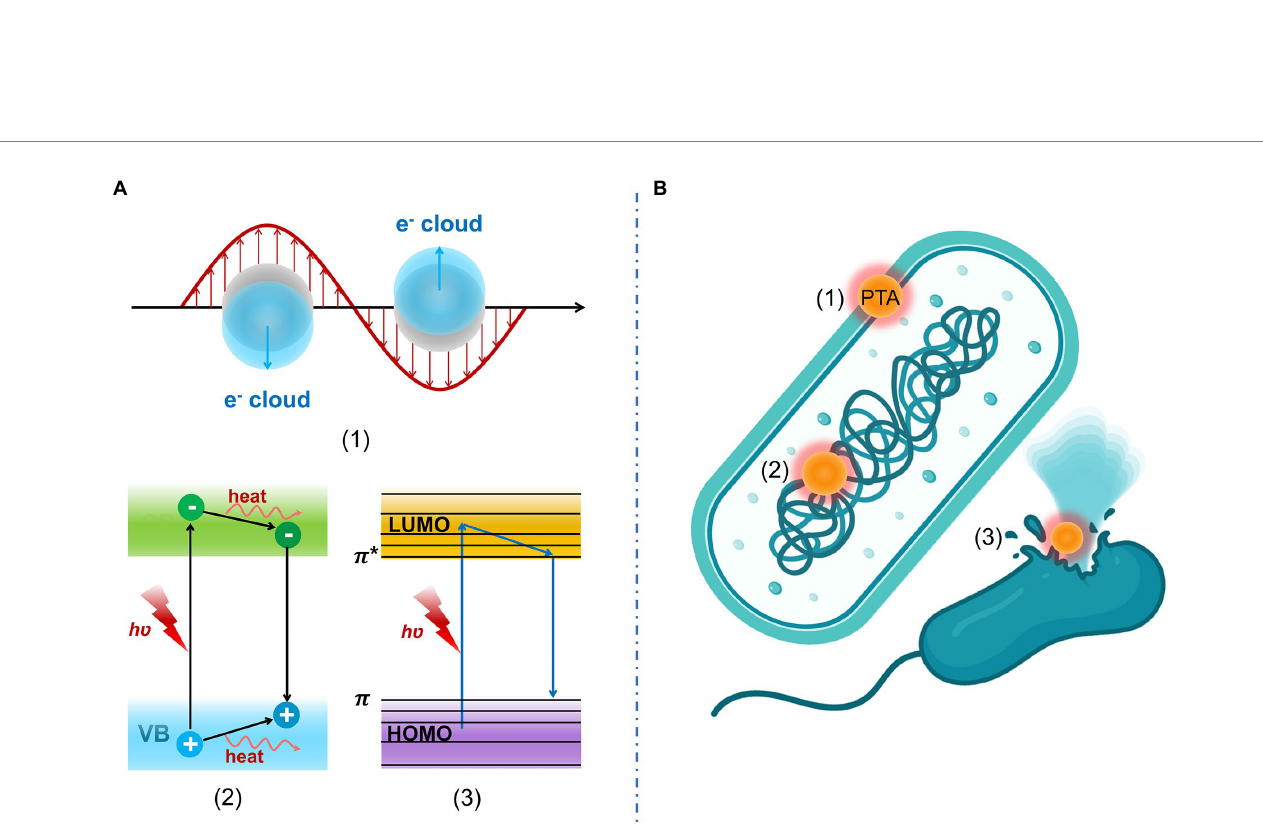
FIGURE 2 (A) Photothermal conversion mechanism including (1) plasmonic heating, (2) electron–hole generation and relaxation, and (3) thermal vibration of molecules. (B) Antibacterial mechanisms of PTT include (1) increased membrane permeability, (2) bacterial protein denaturation, and (3) irreversible bacterial